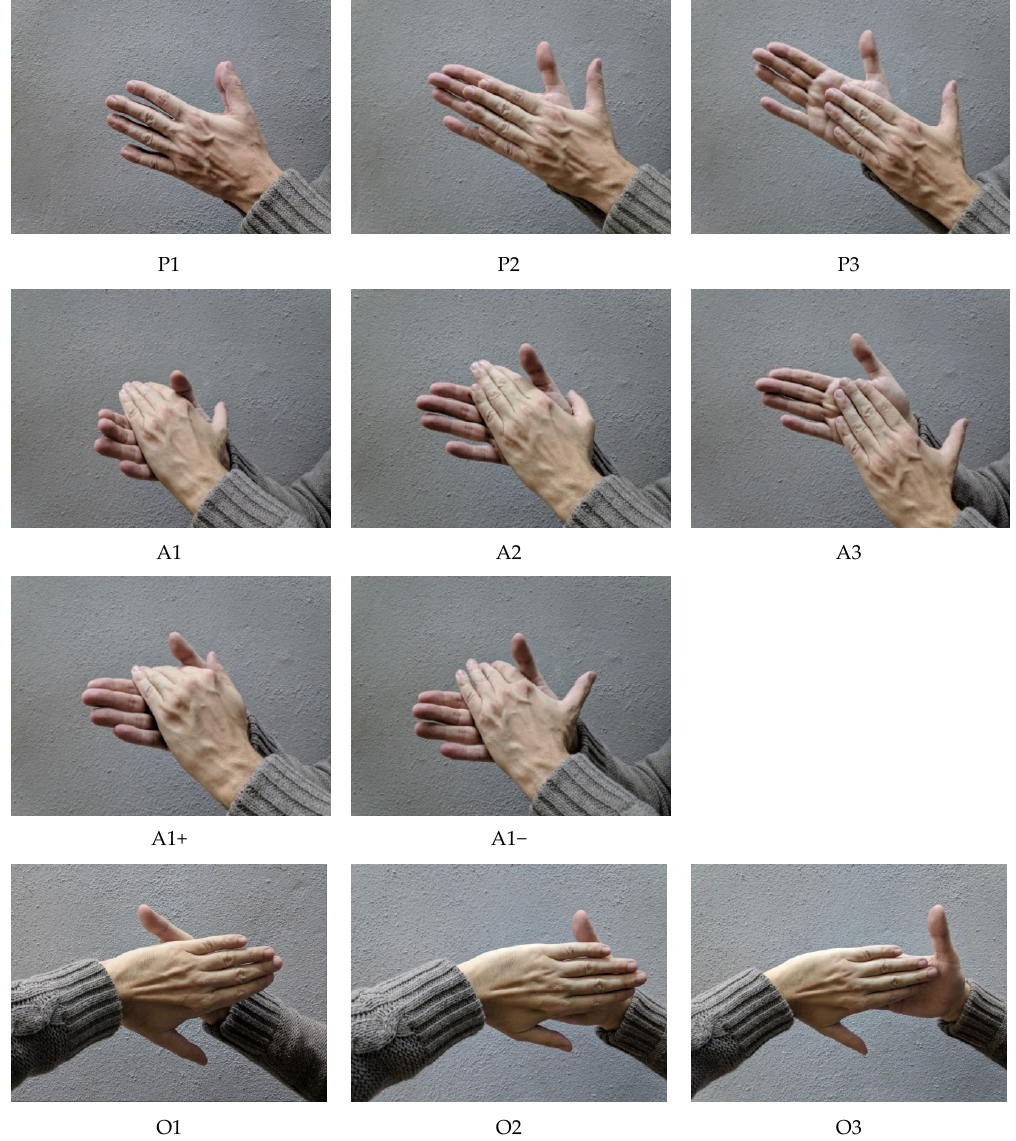
Figure 1. Different hand configurations that were used during the measurements ( P : parallel hand configurations, A : aligned hand configurations, O : opposite hand configurations).